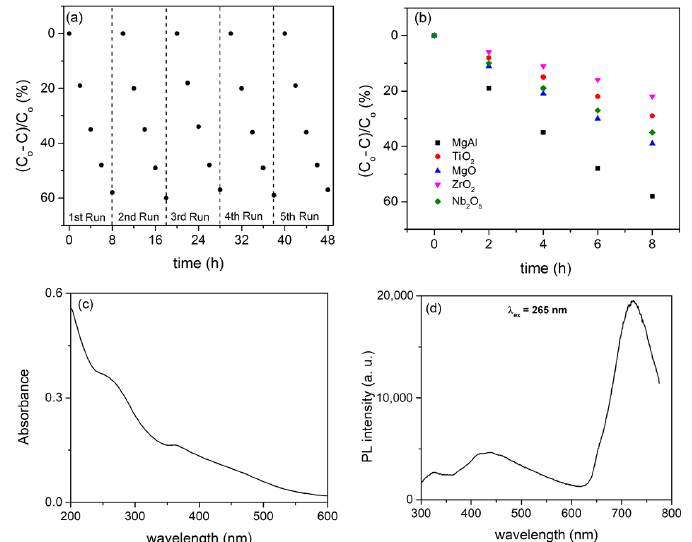
Figure 3. ( a ) PA of MgAl coating; ( b ) PA for different coatings formed by PEO process; ( c ) DRS of MgAl coating; ( d ) PL of MgAl coating.